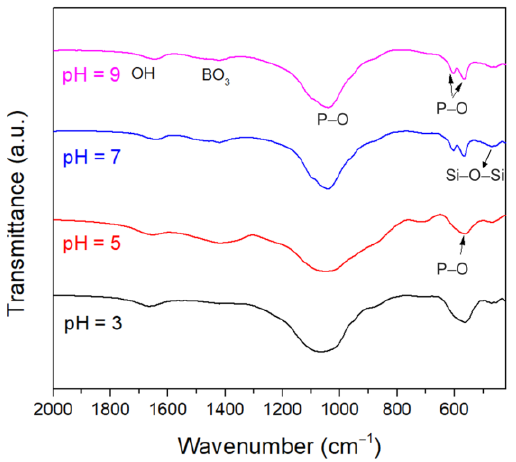
Figure 8. FTIR spectra of the glass samples immersed in K 2 HPO 4 solutions with different initial pH for 20 days.